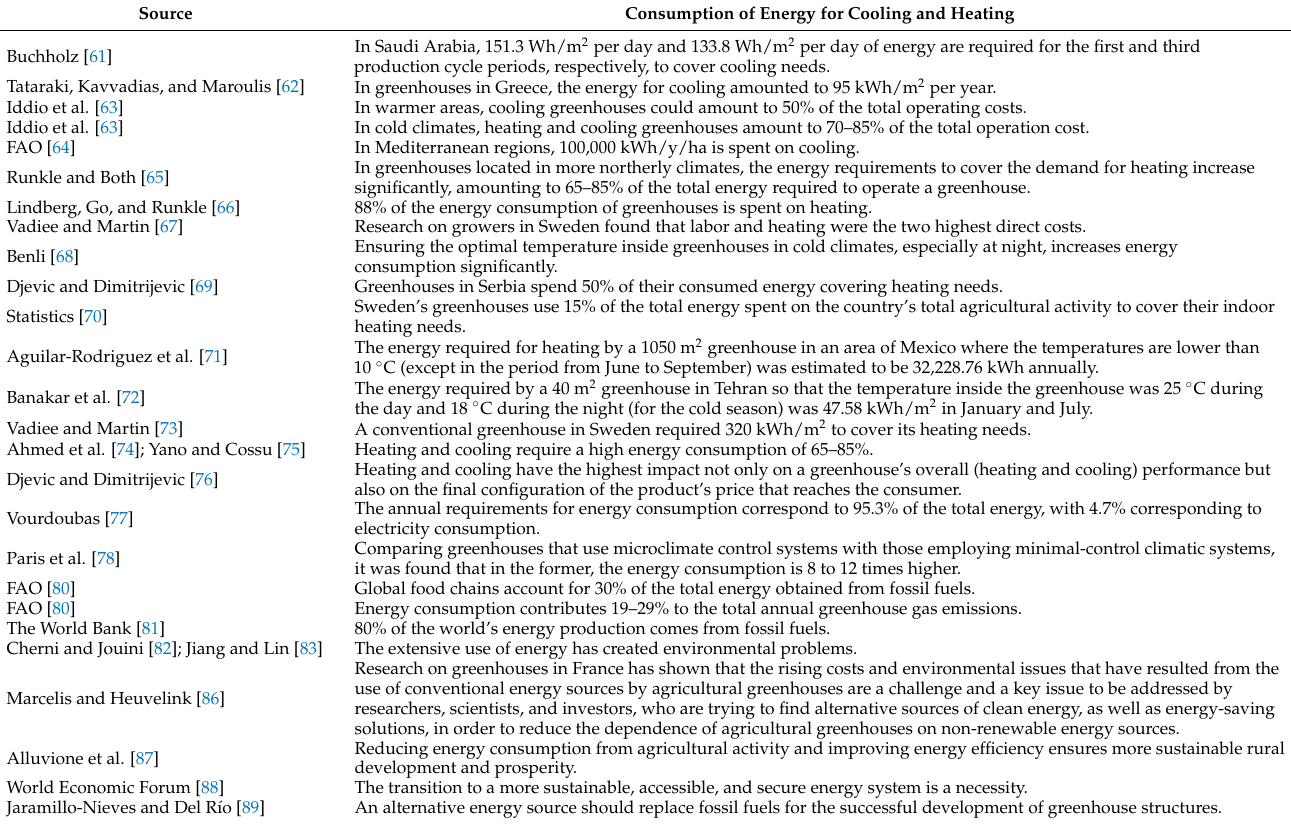
Table 3. Energy consumption for cooling and heating from conventional